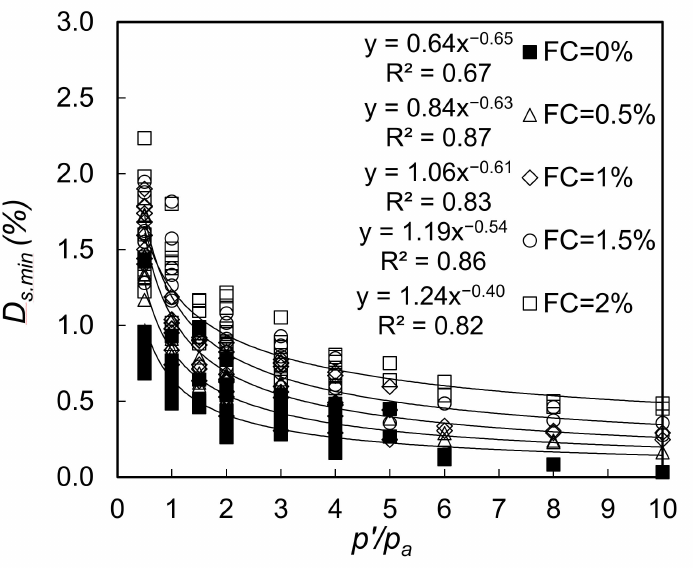
Figure 10. Variation of small-strain damping ratio with normalized confining pressure for all tested sands with different fiber